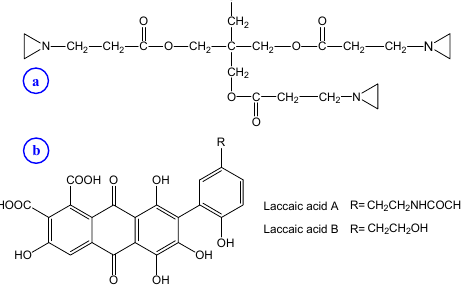
Figure 1. Chemical structures of Crosslinker SaC-100 ( a ) and two major colorant species present in lac dye ( b ).